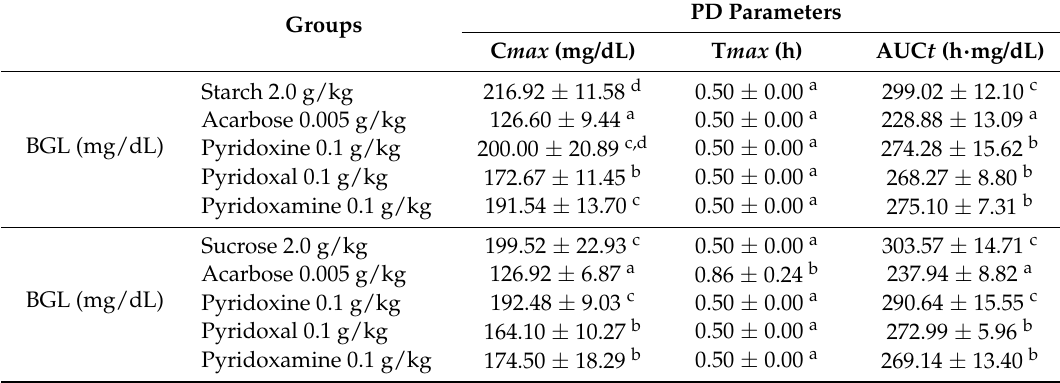
Table 2. Pharmacodynamic (PD) parameters of control, pyridoxine, pyridoxal, pyridoxamine, and Acarbose in SD rats ingested with starch or